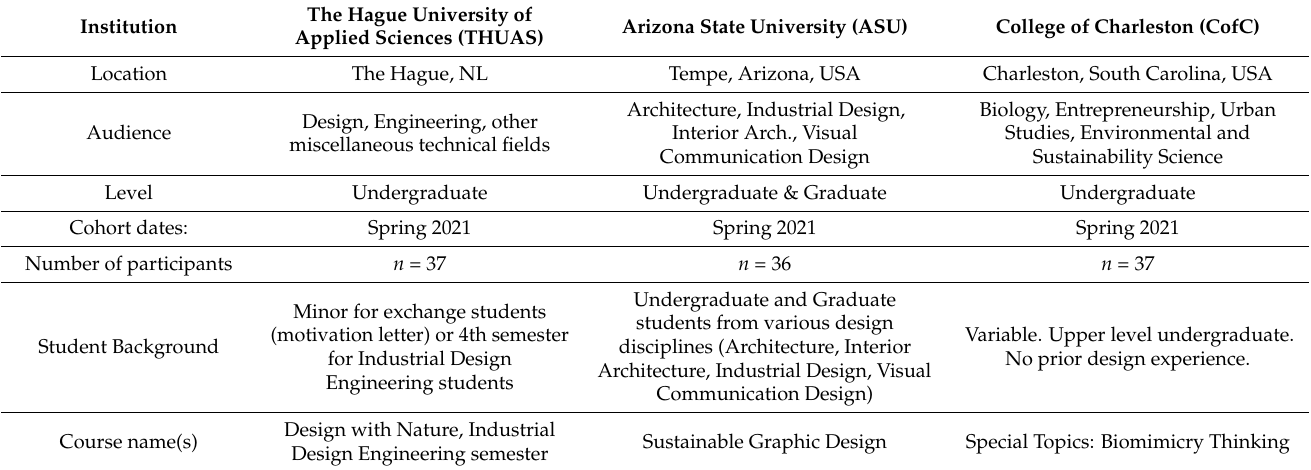
Table 1. Research context, cohort